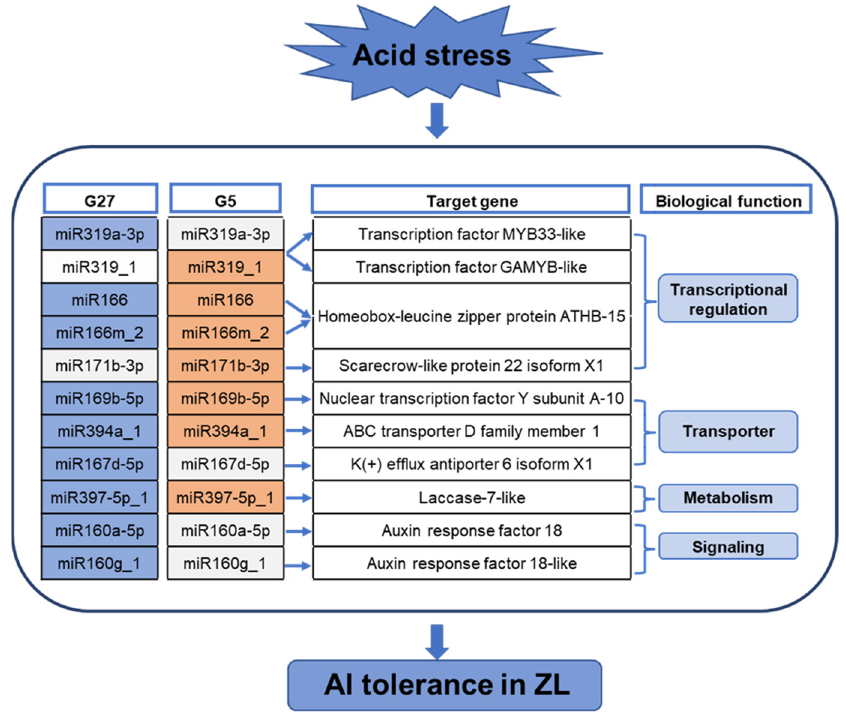
Figure 8. Hypothetical regulatory model involving miRNA and their target genes in Al-tolerance of ZL. Colors in the heatmap represent the up-regulated (orange), unchanged (grey) or down-regulated (blue) of each miRNA in response to Al stress.